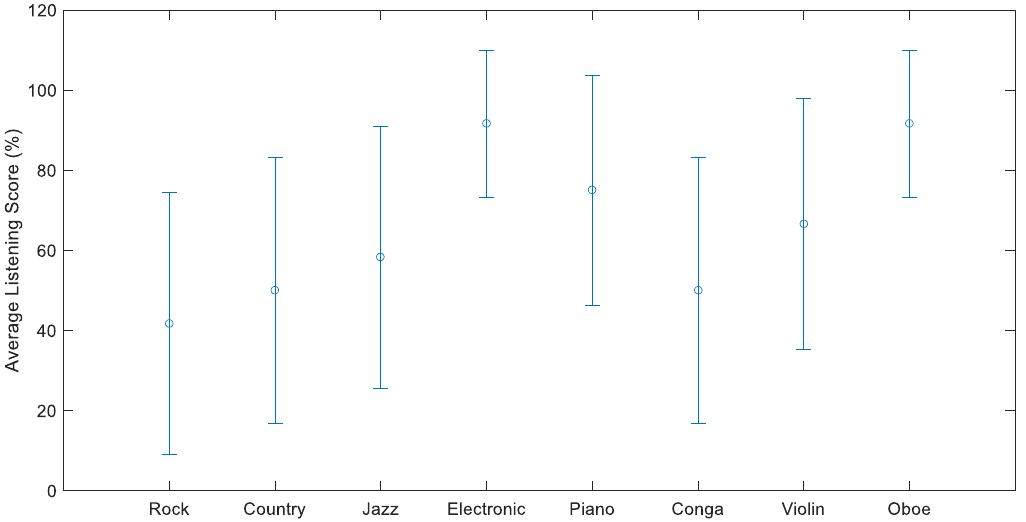
Figure 15. System efficiency and effectiveness evaluated in terms of means and 95% confidence intervals of listening scores.